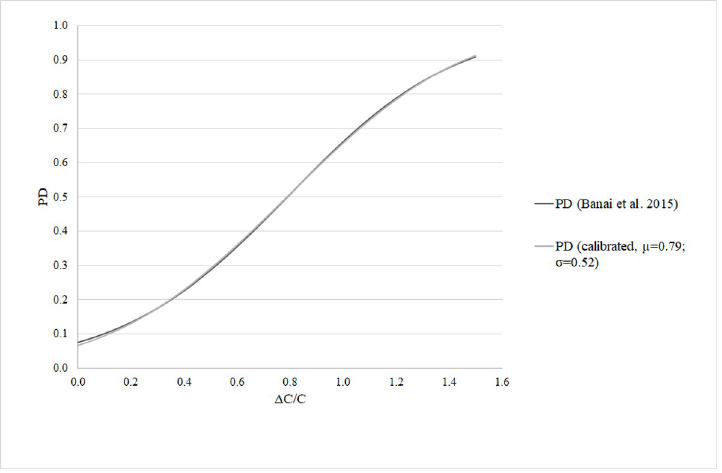
Fig 1. Probability of default in the function of the percentage change in mortgage payments. Fig 1 presents the empirical PD function in function of the percentage change in the repayment C based on [34] and the calibrated PD curve we use in the stress test. The two curves are very close to each